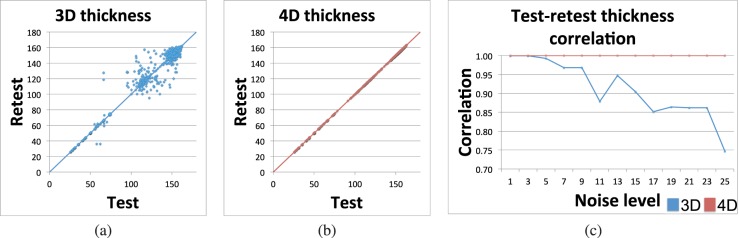
Choroid thickness consistency in the presence of simulated speckle noise. (a) Test–retest choroid thickness measurements (μm) for cross-sectional (3D) segmentation. y = x line is shown for reference. (b) Test–retest choroid thickness measurements (μm) for longitudinal (4D) segmentation. y = x line is shown for reference. (c) Correlation of test–retest choroid thickness measurements per noise level (σ of Gaussian kernel). High correlation corresponds to highly consistent measurements. Four-dimensional (red) measurements were significantly more consistent than 3D (blue) measurements (P < 0.002).